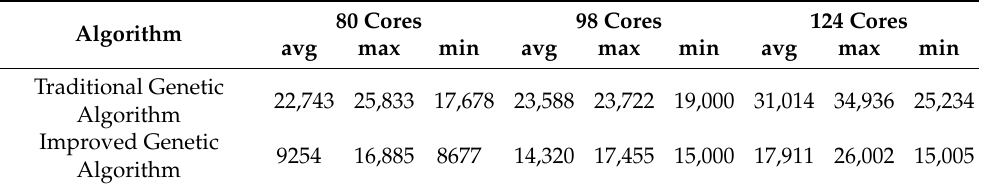
Table 2. Random task graph power consumption comparison (Continued) (mJ).